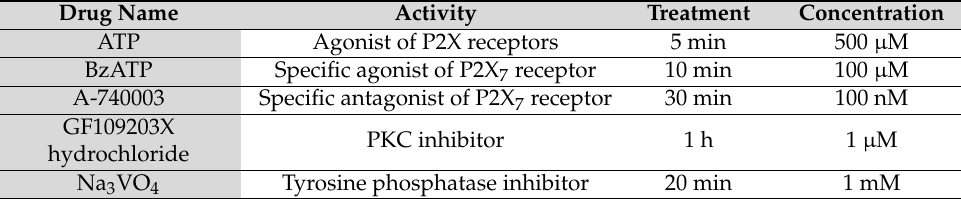
Table 1. List of agonists and inhibitors and concentration